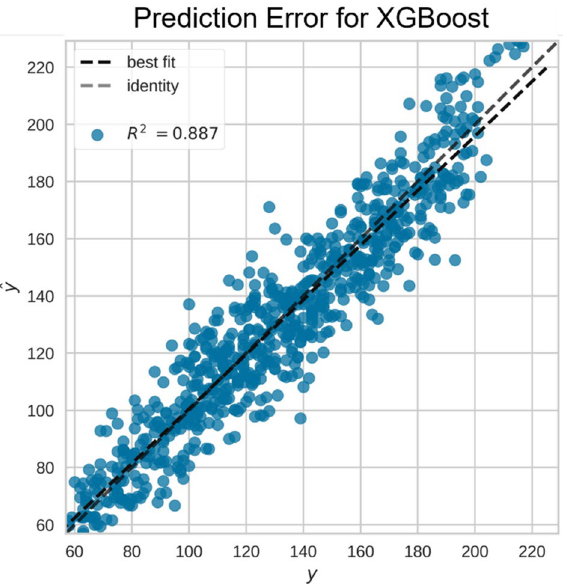
Figure 8. Prediction error plot on the seasonal heat variation test set using the XGBoost